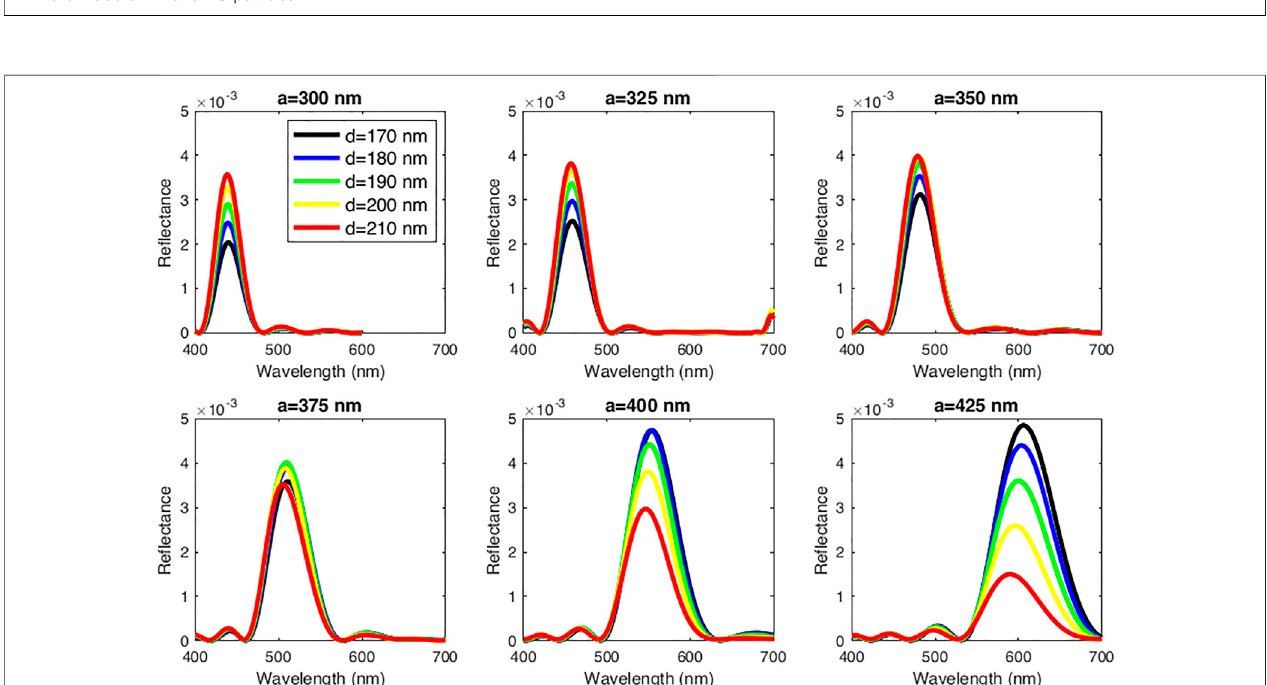
FIGURE 4 | Simulated re fl ection spectra assuming an FCC crystal with different lattice constants a and particle diameters d .